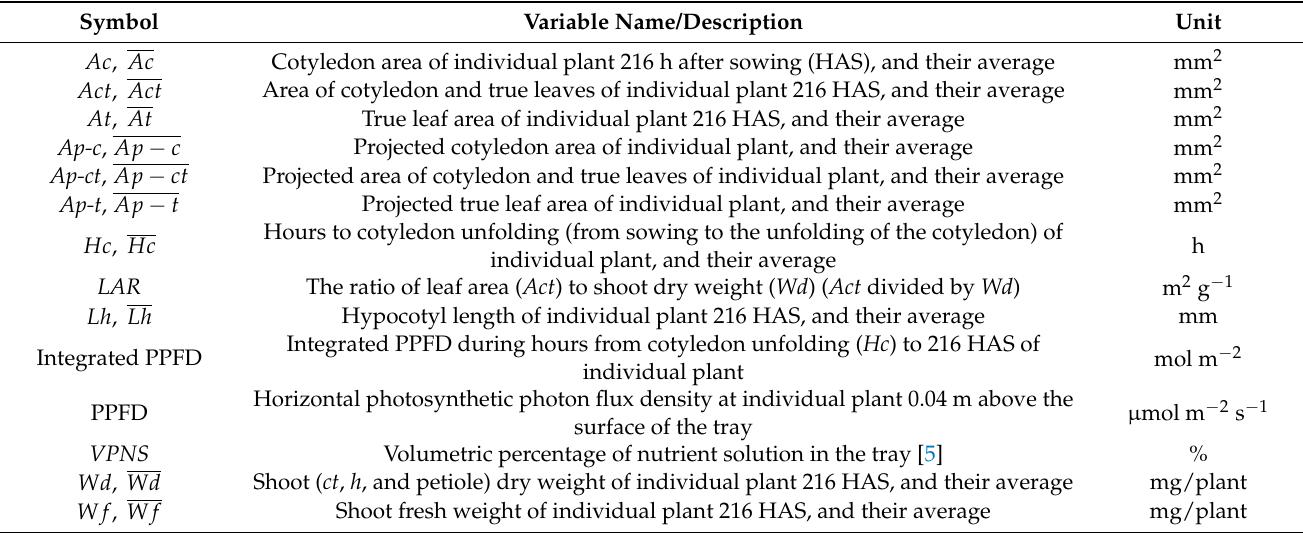
Table 2. List of symbols, variable names with descriptions and